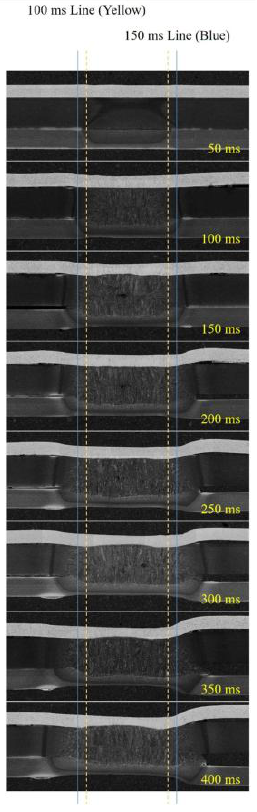
Figure 1. Nugget growth as a function of welding time.